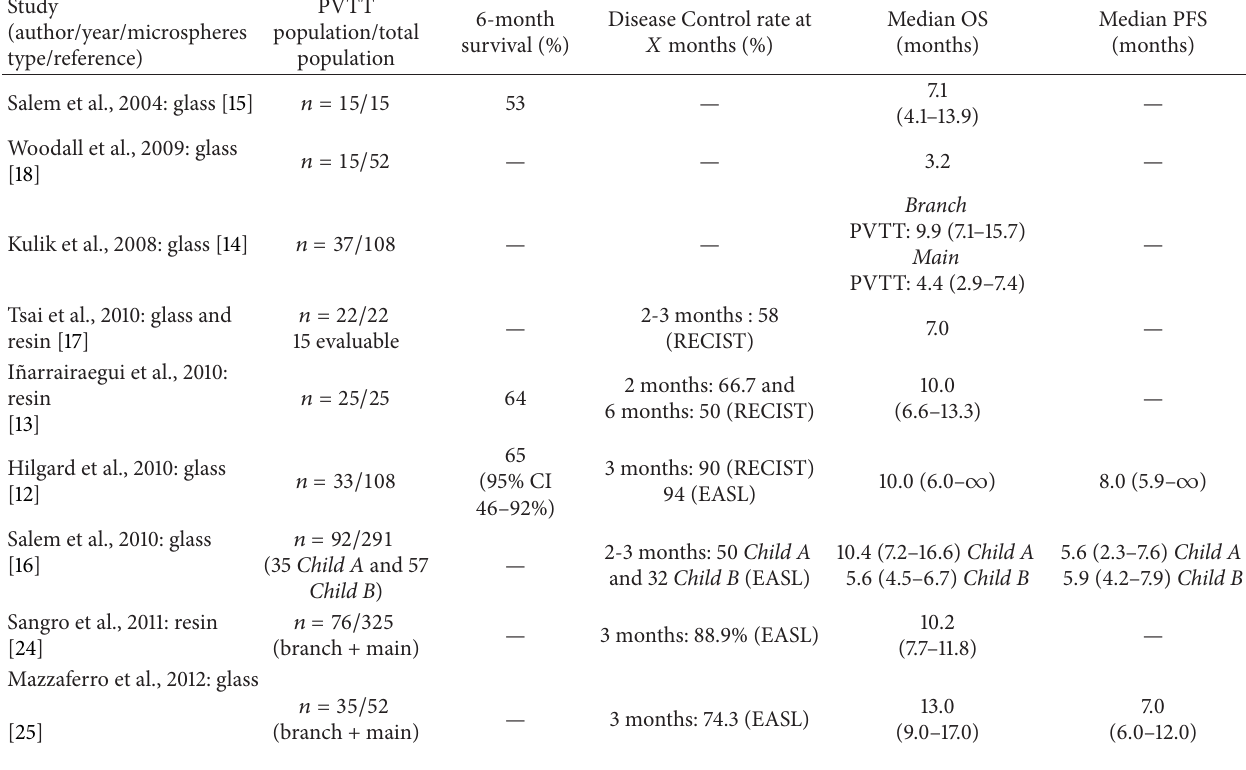
Table 4: Published studies on the treatment of HCC with PVTT with